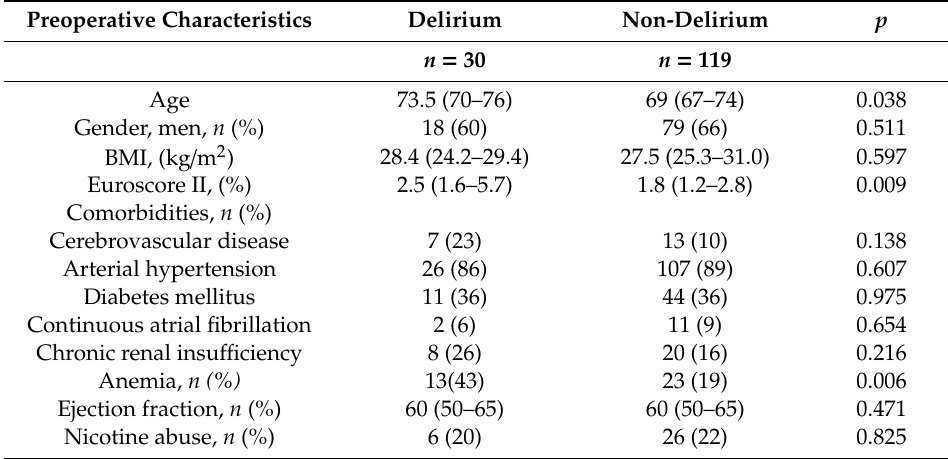
Table 1. Preoperative characteristics: an analysis comparing characteristics of subjects who developed delirium and those who did